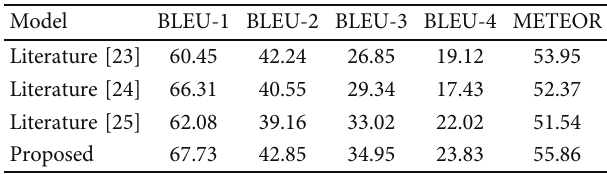
Figure 7: Comparison of experimental results of di ff erent models on the Flickr30k Table 2: Comparison results of the proposed model with other methods on the VATEX dataset.